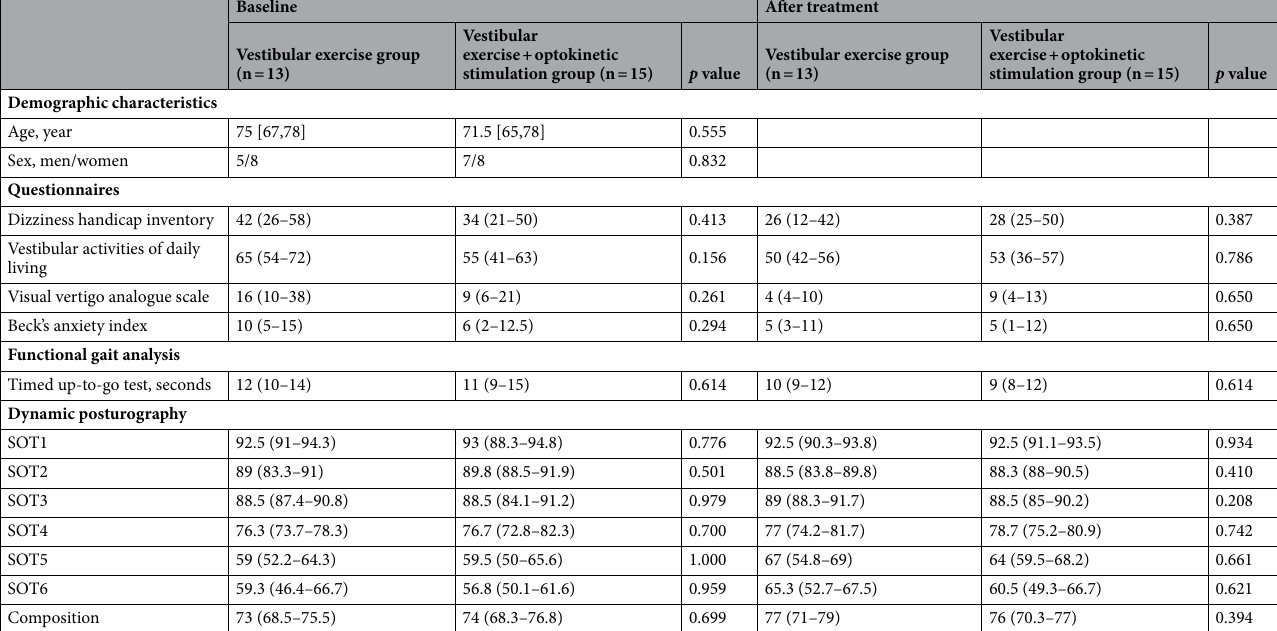
Vestibular exercise + optokinetic stimulation group (n = 15) p